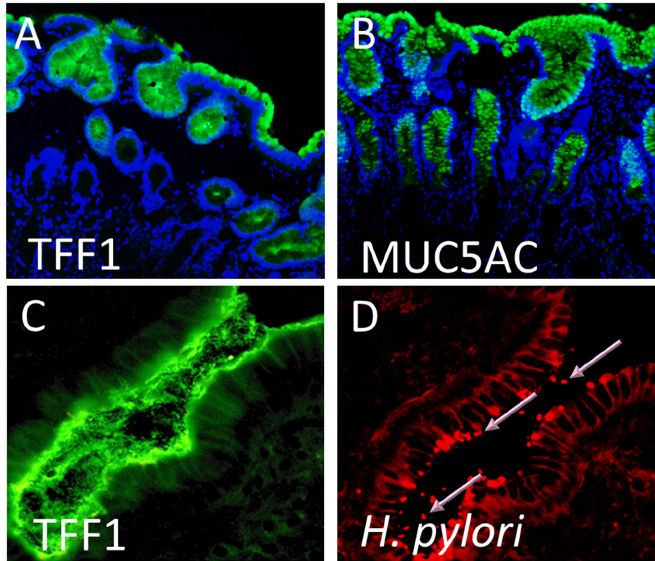
(green) and MUC5AC (green) staining occurred on gastric surface foveolar cells and in the glands. Cell nuclei were counter stained with DAPI (blue). Original magnification 100 × . A frozen section of H. pylori infected antral gastric biopsy tissue was immunofluorescently stained using specific antibodies against ( C ) TFF1 and ( D ) H. pylori . Both TFF1 (green) and H. pylori (red) were detected at the epithelial surface and in the overlying gastric mucus. Pink arrows indicate H. pylori organisms staining bright red. The same field is shown in ( C , D ). Original magnification 200 ×